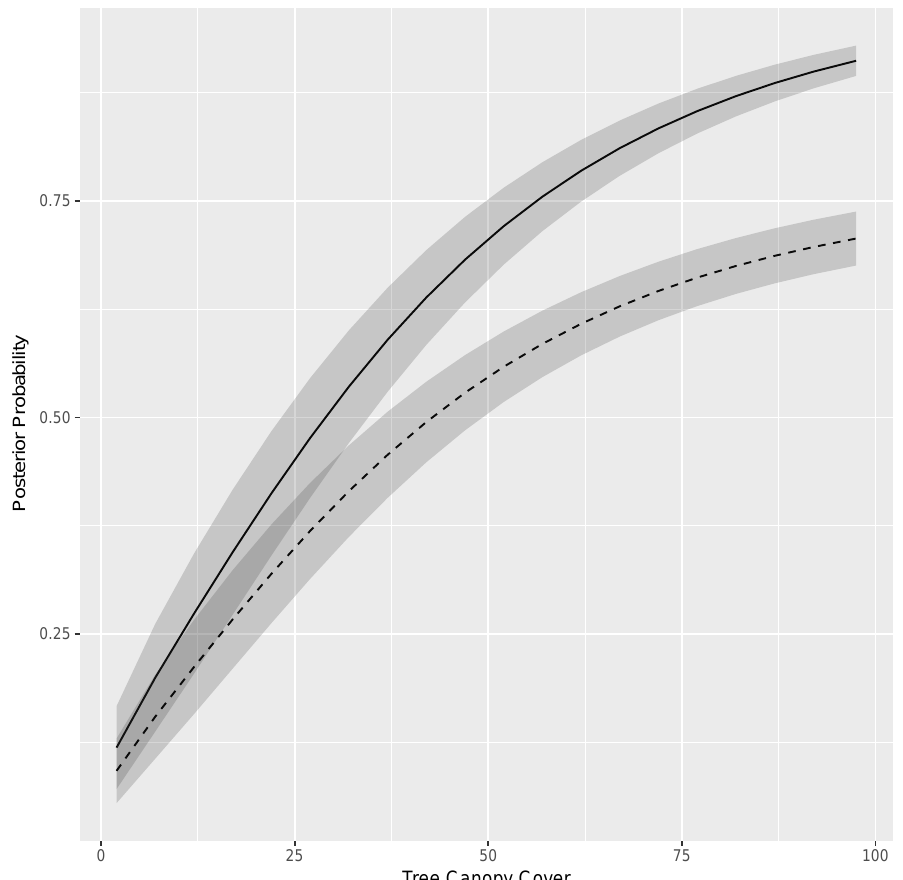
Figure 2. Posterior probabilities and standard error for Forest (solid) and Eastern Softwood (dashed). Only NLCD class 42 in the Piedmont survey unit is shown. While auxiliary data were predicted or imputed from a model such as that used here, it is obvious that there is some uncertainty in the